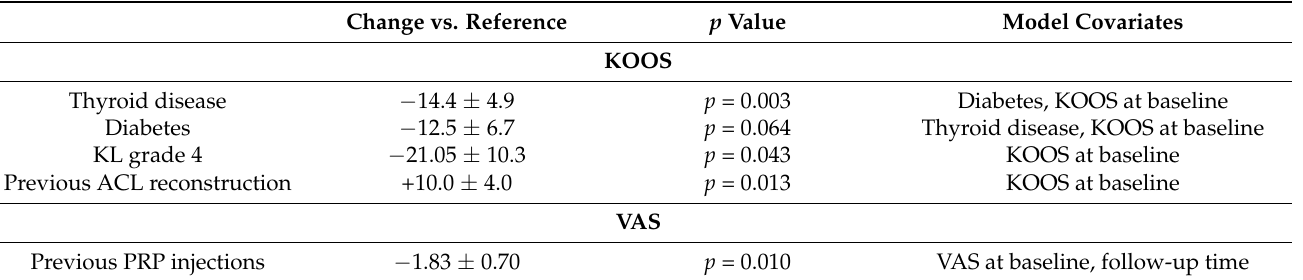
Table 3. Adjusted differences in KOOS and VAS scores at the last follow-up in patients with different